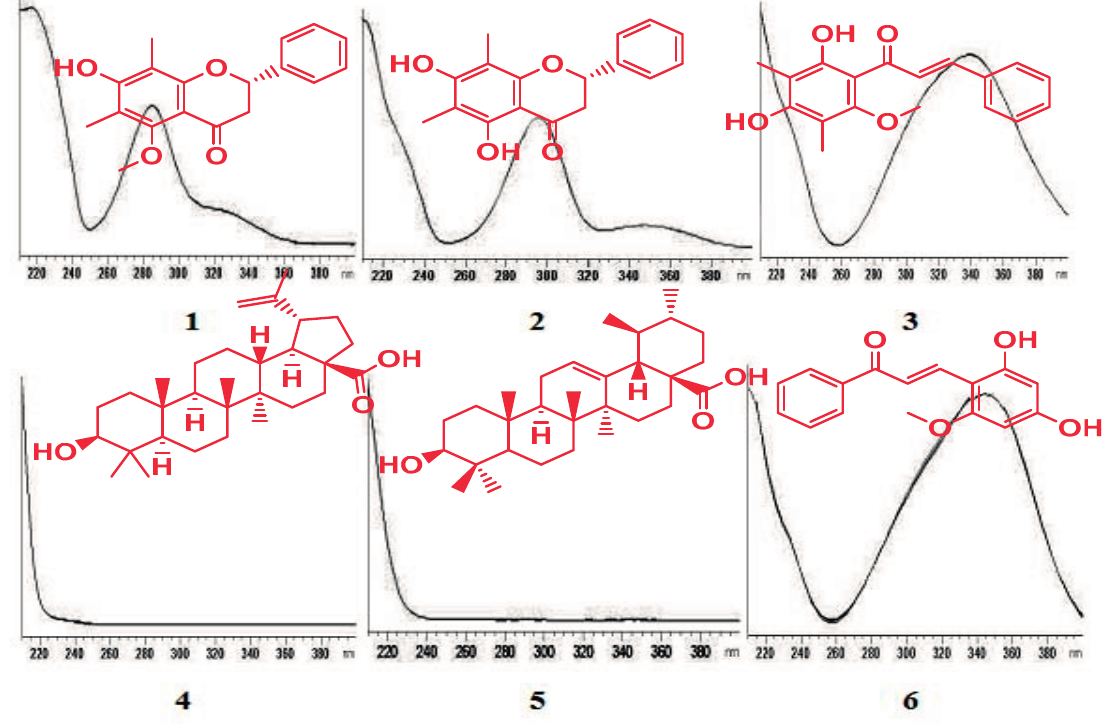
Figure 1. UV-spectra of compounds: (2 S )-7-Hydroxy-5-methoxy-6,8-dimethyl flavanone ( 1 ), ( S )-5,7-dihydroxy-6,8-dimethyl flavanone ( 2 ), ( E )-2 ʹ ,4 ʹ -dihydroxy-6 ʹ -methoxy-3 ʹ ,5 ʹ - dimethylchalcone ( 3 ), Betulinic acid ( 4 ) Ursolic acid ( 5 ) and ( E )-2 ʹ ,4 ʹ -dihydroxy-6 ʹ - methoxy chalcone ( 6